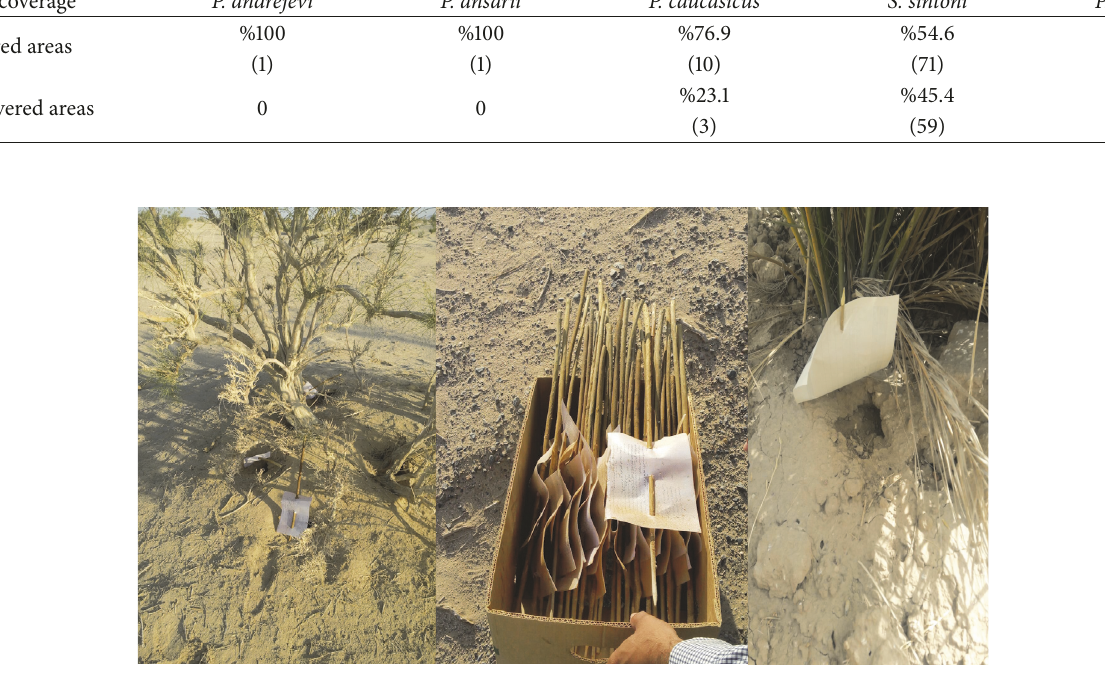
Figure 2: A sampling site in the outskirts of Yazd (the burrows of gerbils can be seen in the picture).